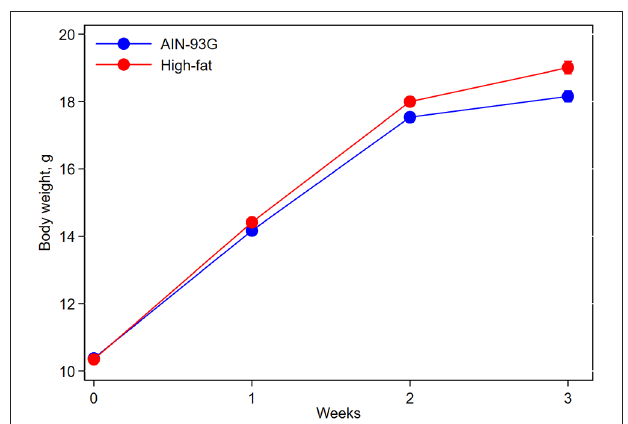
FIGURE 1 | Body weight of pubertal mice fed AIN93G or high-fat diet. Mice fed high-fat diet were slightly heavier than mice fed AIN93G diet. The difference was significant at week 2 ( p < 0.05) and week 3 ( p < 0.01) after the high-fat diet ( n = 70 per